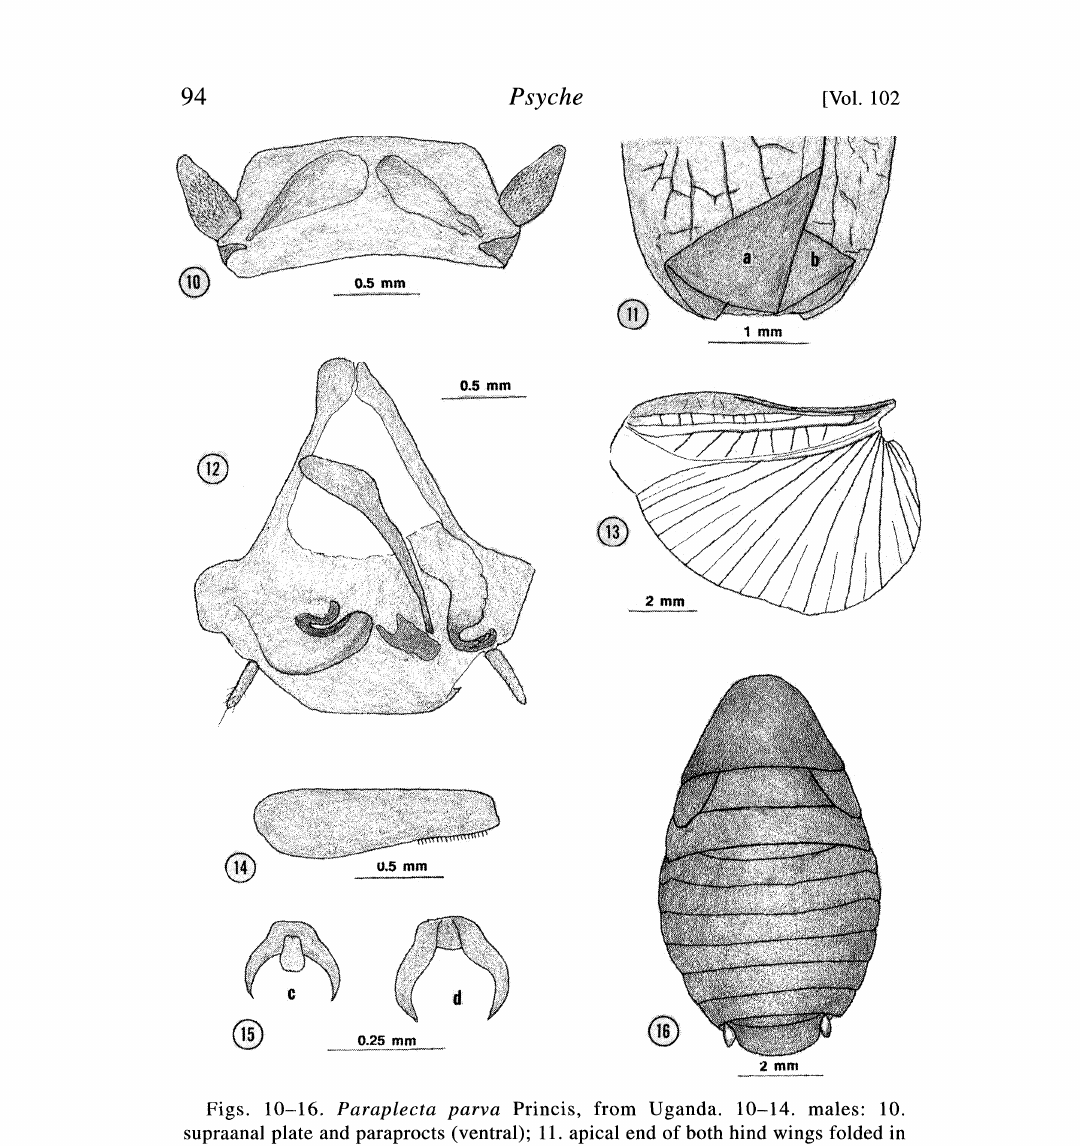
Figs. 10-16. Paraplecta parva Princis, from Uganda. 10-14. males: 10. supraanal plate and paraprocts (ventral); 11. apical end of both hind wings folded in the resting position (dorsal; a and b left and right wings respectively); 12. subgen- ital plate and genitalia (dorsal); 13. left hind wing; 14. front femur (anterior sur- face); 15. tarsal claws (c male, with arolium; d female, arolium absent); 16. female